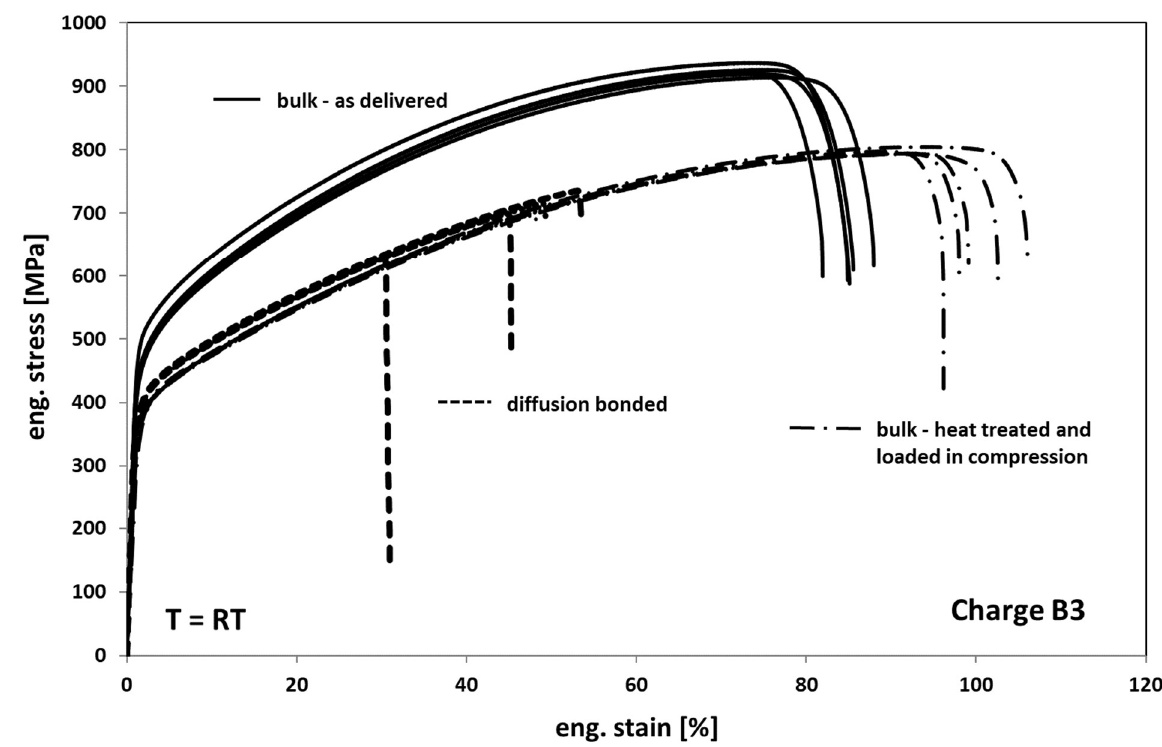
Figure 8. Tensile response of Hastelloy B3 in di ff erent